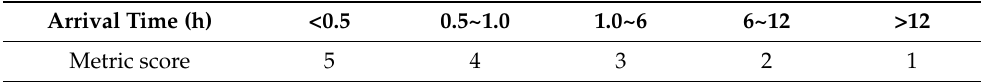
Table 5. Oil slick arrival time index score.